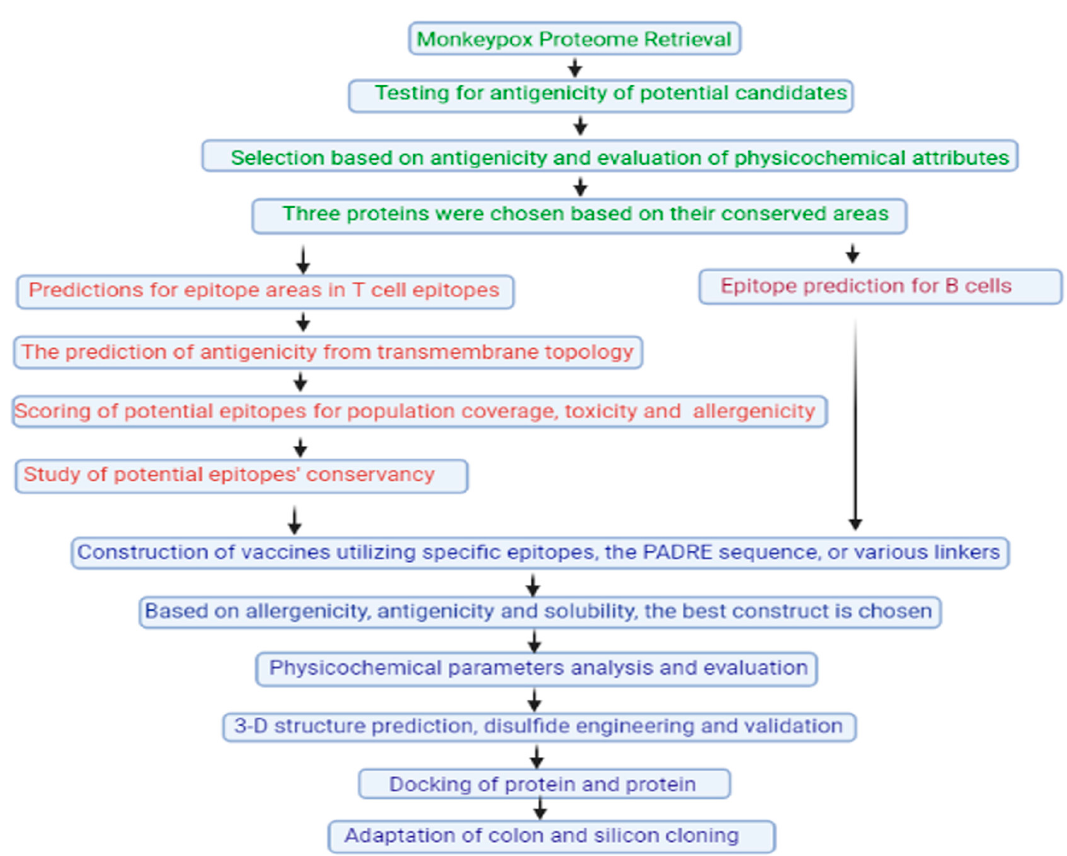
Figure 3. A simplified flowchart illustrating the steps taken to create an effective vaccination for monkeypox using epitopes [66].